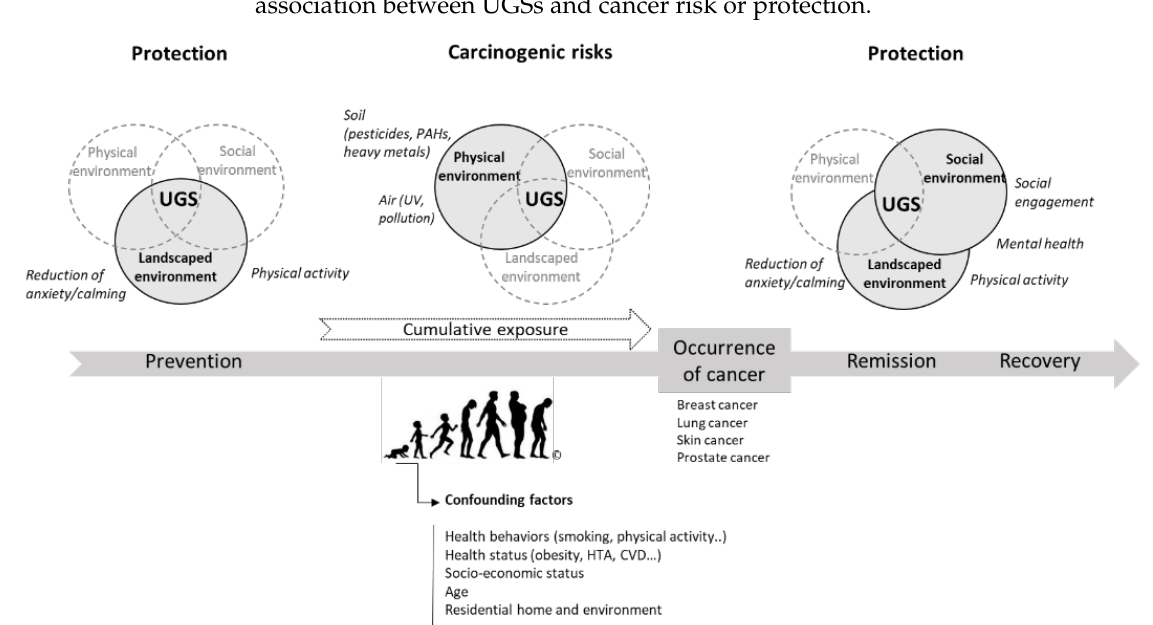
Figure 3. Identification of major components of UGSs (physical, social and landscaped environment) and their mediating factors (text in italics) related to the risk or protection of cancer prevention, occurrence, remission and recovery from the 10 studies (on 29) demonstrating a link between UGSs and cancer. Doted lines indicate the component on which research should be developed. Picture: © Robert Adrian Hillman.